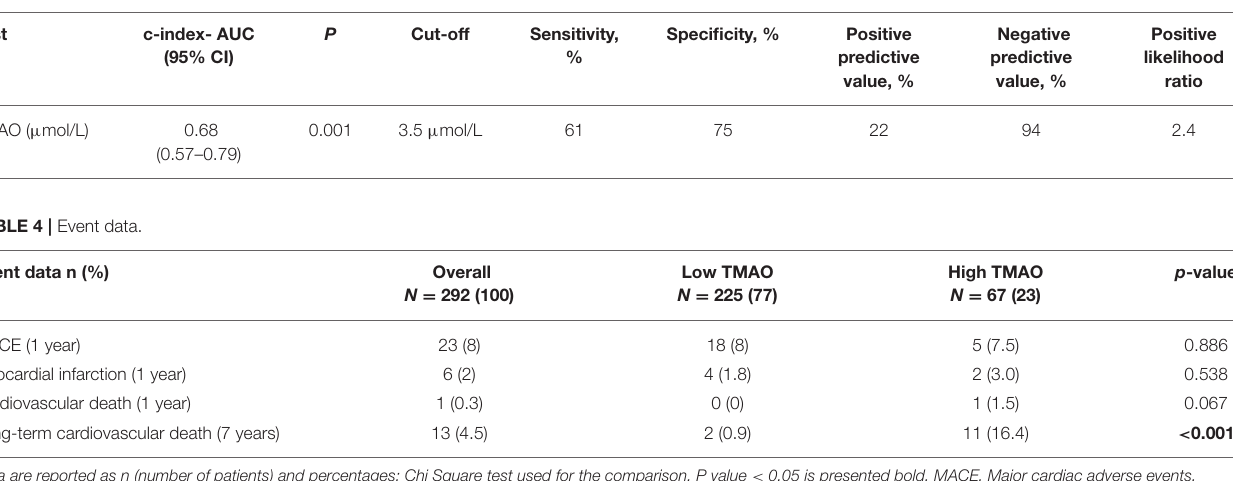
TABLE 3 | Statistical estimates for prediction of all-cause of death by TMAO.